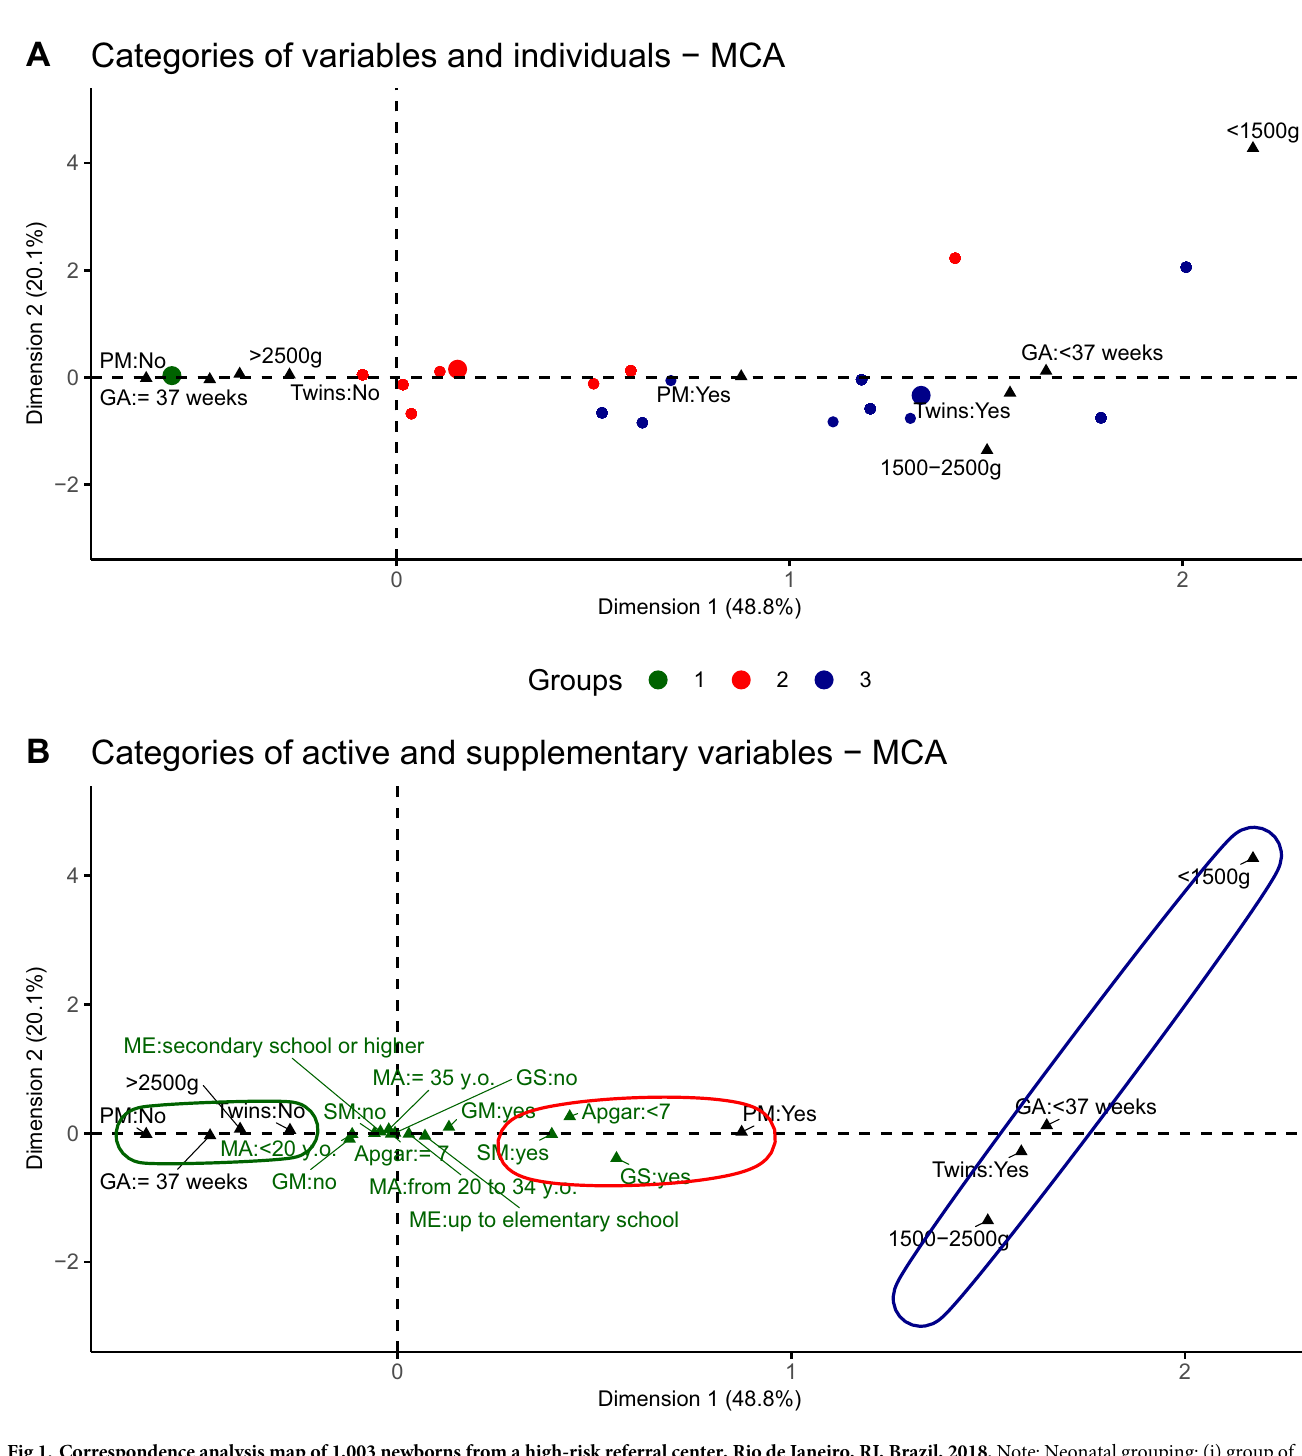
Fig 1. Correspondence analysis map of 1,003 newborns from a high-risk referral center, Rio de Janeiro, RJ, Brazil, 2018. Note: Neonatal grouping: (i) group of healthy full-term newborns; (ii) risk group 1—characterized by NBs with surgical morbidities and genetic syndrome; (iii) risk group 2—characterized by preterm and low birth weight NBs. PM = perinatal morbidity; SM = surgical morbidity; GM = gestational morbidity; GA = gestational age; GS = genetic syndrome; ME = maternal education; MA = maternal age. Log-rank <